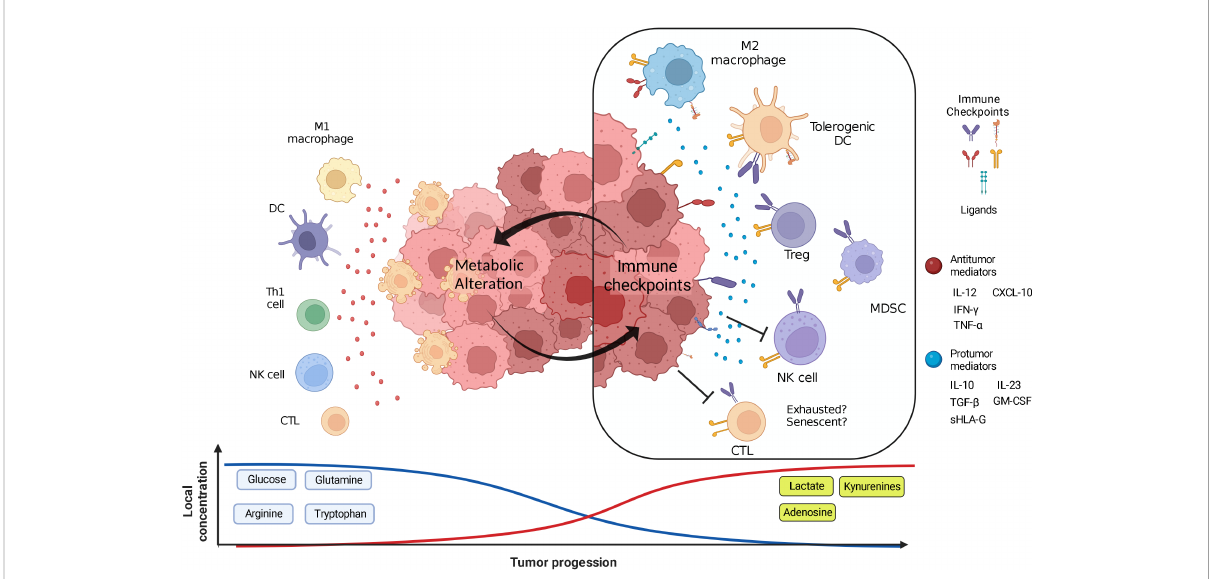
FIGURE 1 Metabolic shifting in the TME and its relationship with immune checkpoints. In early stages of tumor development, tumor and immune cells are immersed in a milieu enriched in nutrients such as glucose and amino acids. High nutrient availability allows antitumor immune cells to exert their effector functions, such as the production of soluble mediators against immunogenic and susceptible tumor cells. However, some tumor clones are able to resist the attack of immune cells and continue their uncontrolled proliferation. As a result of the sustained proliferation of tumor cells and the activation of the immune response, nutrients are gradually consumed, and metabolic by-products are accumulated in the TME. These metabolic alterations signal antitumor immune cells to end their effector mechanisms, as well as promote the recruitment and activation of immune cells with tumor-promoting phenotypes. Moreover, metabolic alterations establish a positive feedback loop with the expression of immune checkpoints and their ligands that strengthens the immunosuppressive state at the TME. See the text for detailed information. CTL=Cytotoxic T Lymphocyte, DC= Dendritic Cell, MDSC= Myeloid Derived Suppressor Cells, NK=Natural Killer cell, Th=T helper cell, Treg=Regulatory T cell, ⊥ =Inhibition. Created with